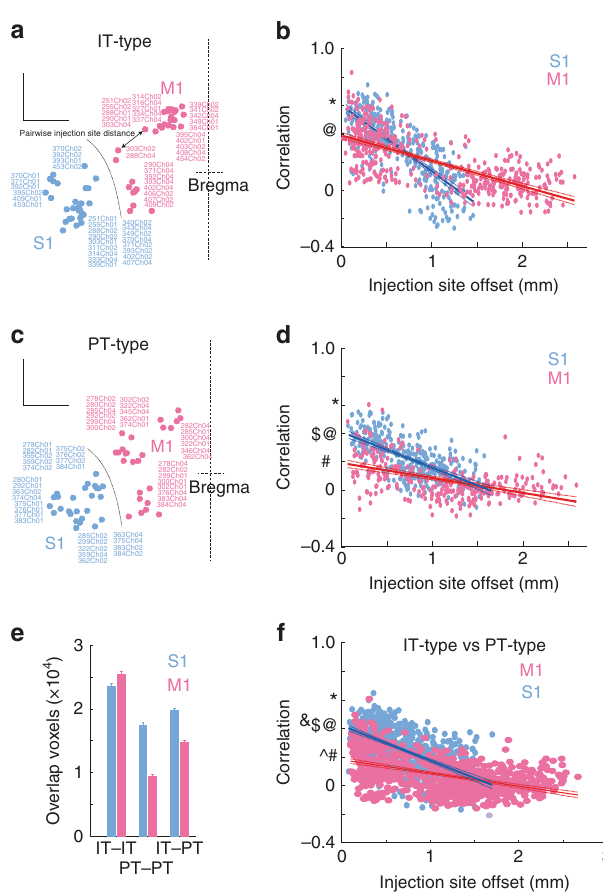
Fig. 4 Corticostriatal topographic precision across cortical areas and cell types. a , b Pairwise correlation between ipsilateral corticostriatal projections from IT-type ( a , b ) and PT-type ( c , d ) neurons was plotted against injection site offset in mm. Scale, 1 mm. a , c Dorsal view of injection sites in CCF coordinates. Midline and bregma indicated at right. Scale bars, 1 mm. All primary sensory (S1) injections are shown in blue and primary motor (M1) injections are shown in pink. Circles indicate injection site with injection number labeled. Double headed arrow indicates injection site offset distance for one pair of injections. b , d , f Correlation versus injection site offset for S1 and M1 injections. N = 351, IT-type vs. IT-type in S1; N = 435, IT-type vs. IT-type in M1; N = 312, PT-type vs. PT-type in S1; N = 300, PT-type vs. PT-type in M1; N = 702, IT-type vs. PT-type in S1; N = 750, IT- type vs. PT-type in M1). Solid line represents linear fi t, with con fi dence interval plotted as dashed lines. Typographic marks indicate y-intercept across panels for comparison. e Mean number of overlapping voxels used to calculate correlations for IT – IT ( b ), PT – PT ( d ) and IT-PT ( f ) comparisons. f Correlation versus injection site offset for comparisons across IT-type and PT-type injections in S1 and M1. Here, each S1 IT-type injection is compared to each S1 PT-type injection but not to other